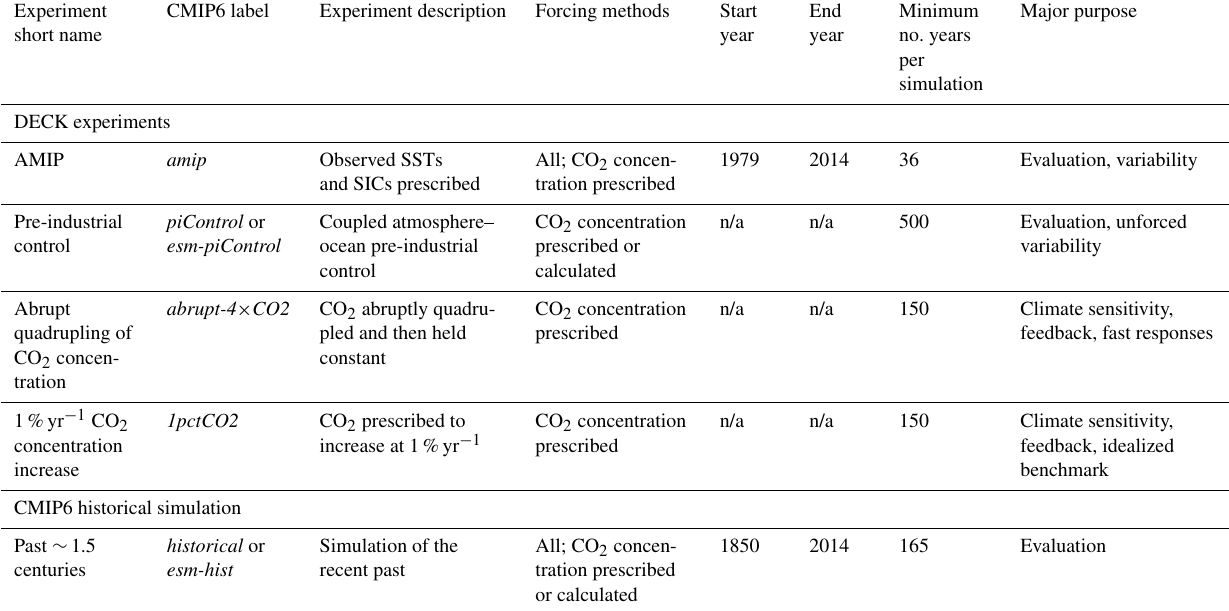
Table 2. Overview of DECK and CMIP6 historical simulations providing the experiment short names, the CMIP6 labels, brief experiment descriptions, the forcing methods, as well as the start and end year and minimum number of years per experiment and its major purpose. The DECK and CMIP6 historical simulation are used to characterize the CMIP model ensemble. Given resource limitations, these entry card simulations for CMIP include only one ensemble member per experiment. However, we strongly encourage model groups to submit at least three ensemble members for the CMIP historical simulation as requested in DAMIP. Large ensembles of AMIP simulations are also encouraged. In the “forcing methods” column, “All” means “volcanic, solar, and anthropogenic forcings”. All experiments are started on 1 January and end on 31 December of the specified